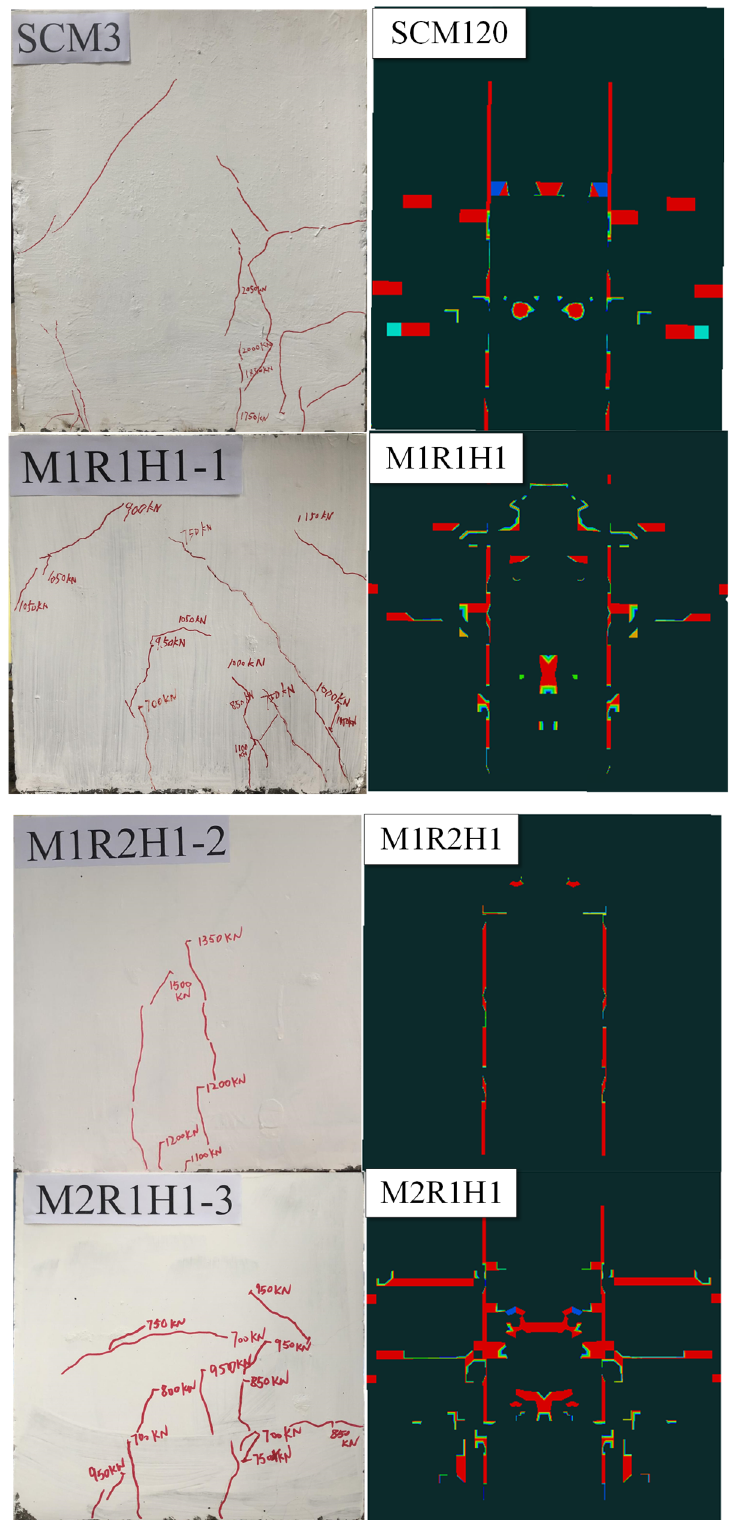
Figure 12. Crack patterns on concrete slab obtained from push-out tests and FE models.